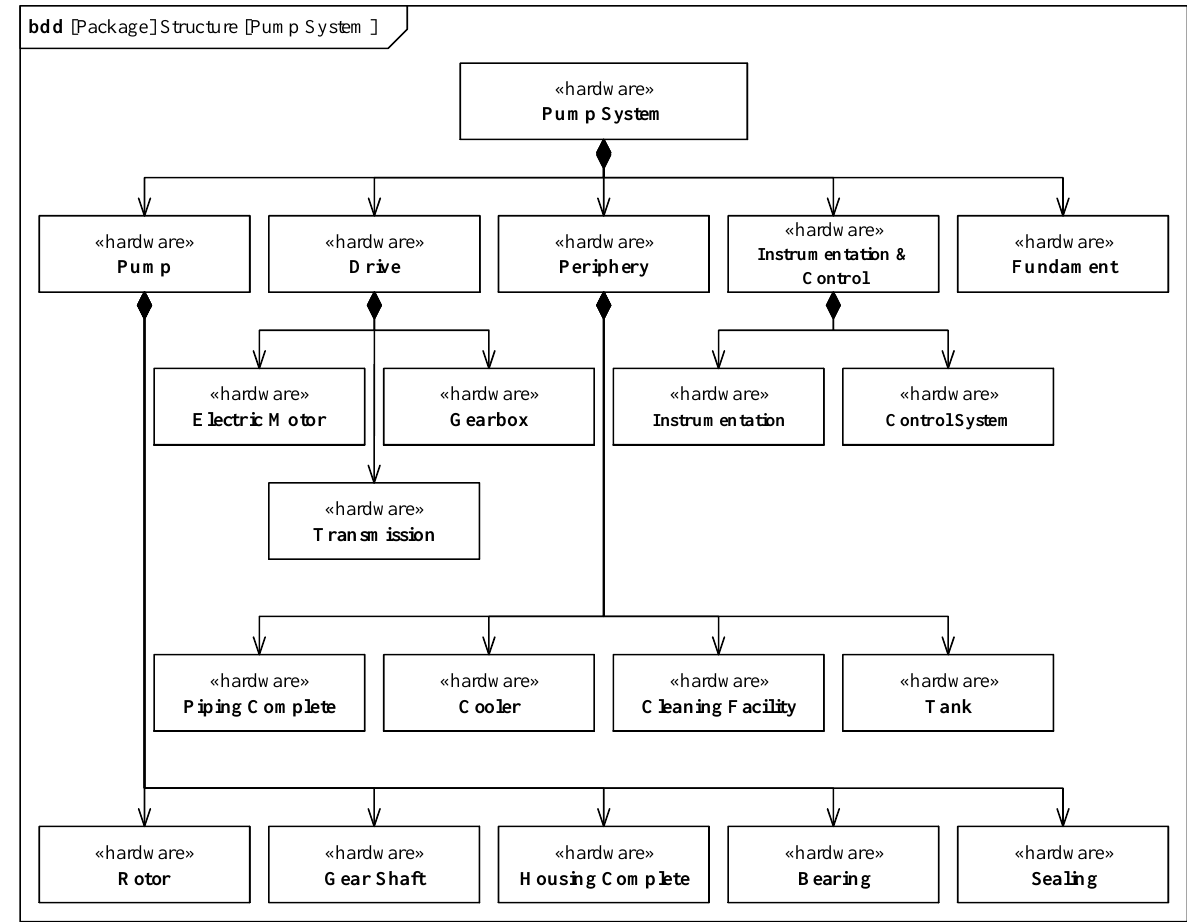
Fig. 7: Equipment line structure of a simplified pump system Figure 7: Equipment line structure of a simplified pump system.